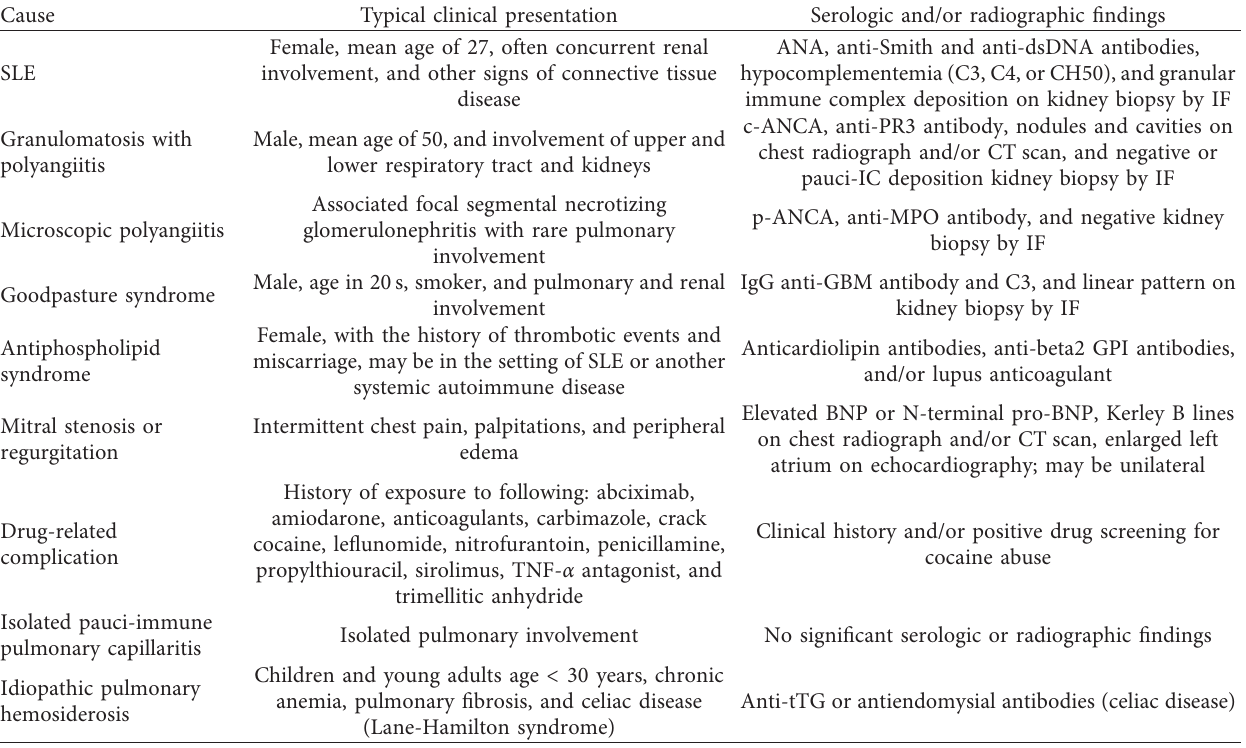
Table 1: Most common noninfectious causes of diffuse alveolar